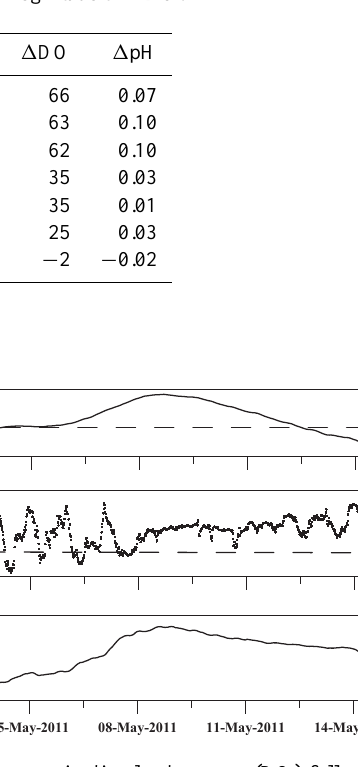
Table 1. Event-scale mean increases in dissolved oxygen ( 1 DO) and pH ( 1 pH) proceeding intrusion of high-density water ( σ > 25.1kgm − 3 ) at 7m water depth. v and u indicate the mean velocity (cms − 1 ) of alongshore and cross-shore currents, respectively, between 5 and 30m for 7d before and after the event. Negative values are equatorward or offshore for v and u , respectively. Positive values of 1 DO and 1 pH indicate mean increases from before to after the event. Events are ordered by magnitude of 1 DO.